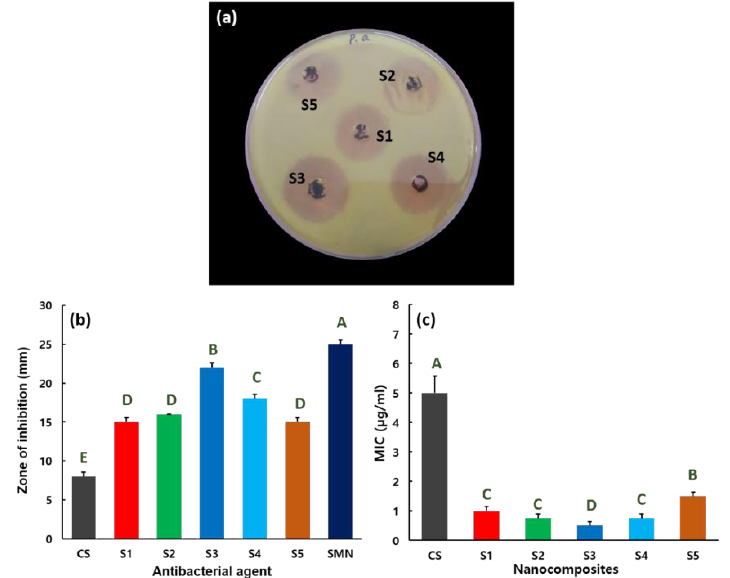
Figure 7. ( a ) Antibacterial activity of nanocomposites S1–S5 nanocomposites versus P. aeruginosa . ( b ) Zone of inhibition for CS, SMN, and nanocomposites S1–S5, with mean ± SD from triplicate tests. Statistical analysis indicated that the values are significantly ( p ≤ 0.05) varied between their experiments, which are indicated by capital letters. ( c ) MIC values for CS and nanocomposites S1–S5 versus P. aeruginosa , with mean ± SD from triplicate tests. Statistical analysis indicated that the values are significantly ( p ≤ 0.05) varied between their experiments, which are indicated by capital letters.